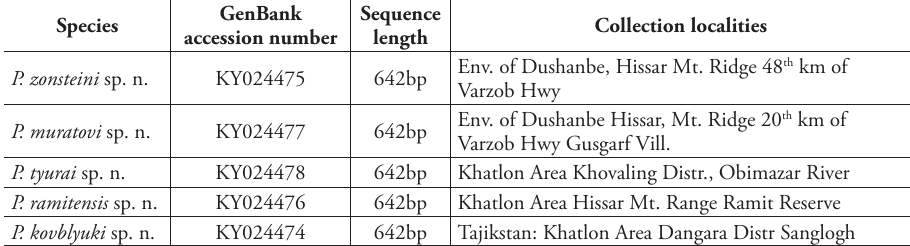
Table 1. Voucher specimen